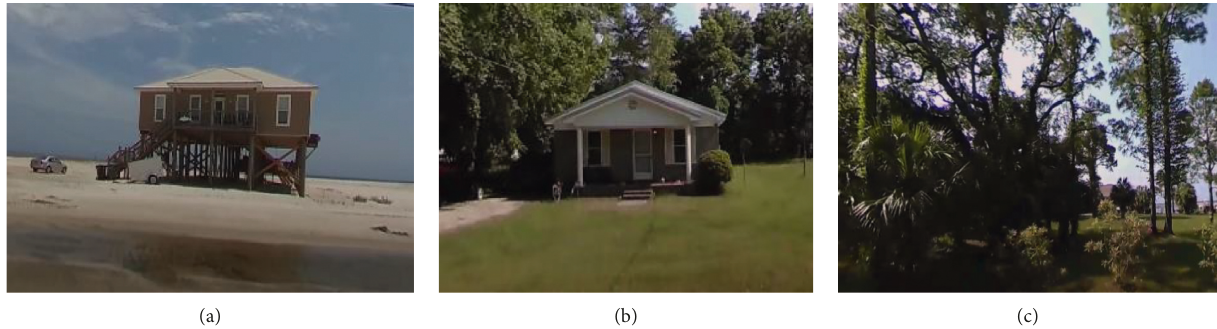
Figure 8: Image classes for deep learning model describing buildings on Dauphin Island. (a) Elevated, (b) nonelevated, and (c)